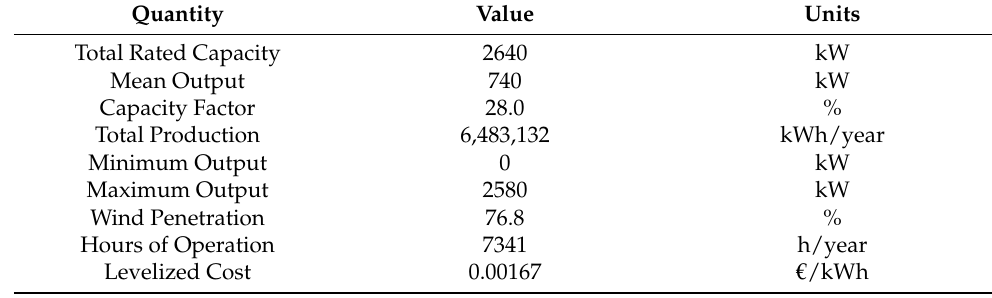
Table 5. Characteristics and parameters of wind turbines.